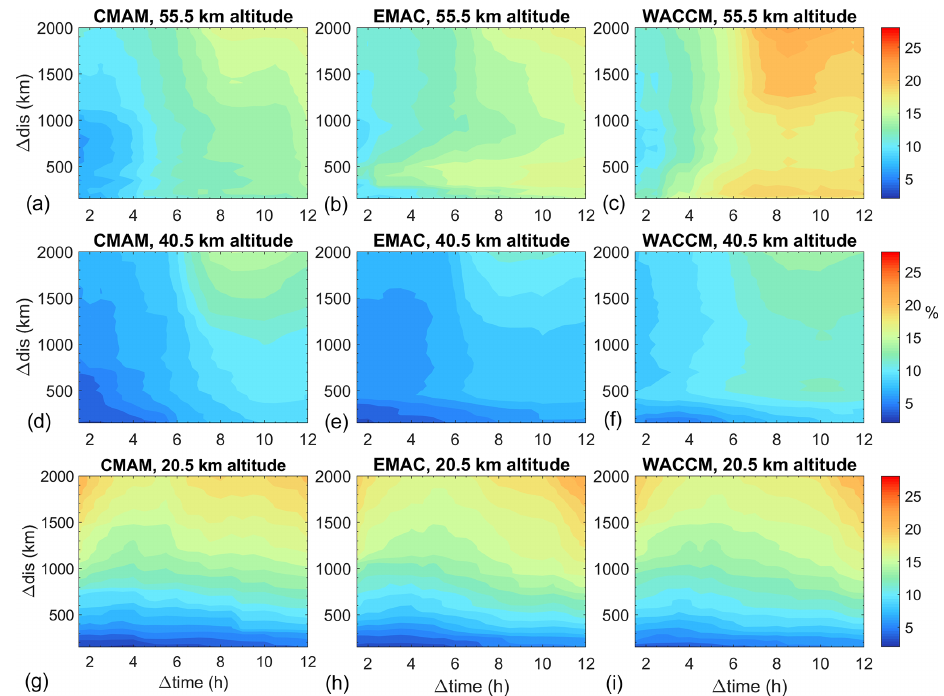
Figure 3. Geophysical variability (2 σ ) between ACE-FTS and OSIRIS O 3 derived from the simulated results of CMAM (a, d, g) , EMAC (b, e, h) , and WACCM (c, f, i) , at altitudes of 20.5km (g–i) , 40.5km (d–f) , and 55.5km (a–c) . Calculations performed for time difference criteria of within 1.5h to within 12h in 0.5h increments and distance difference criteria of within 150km to within 2000km in 50km